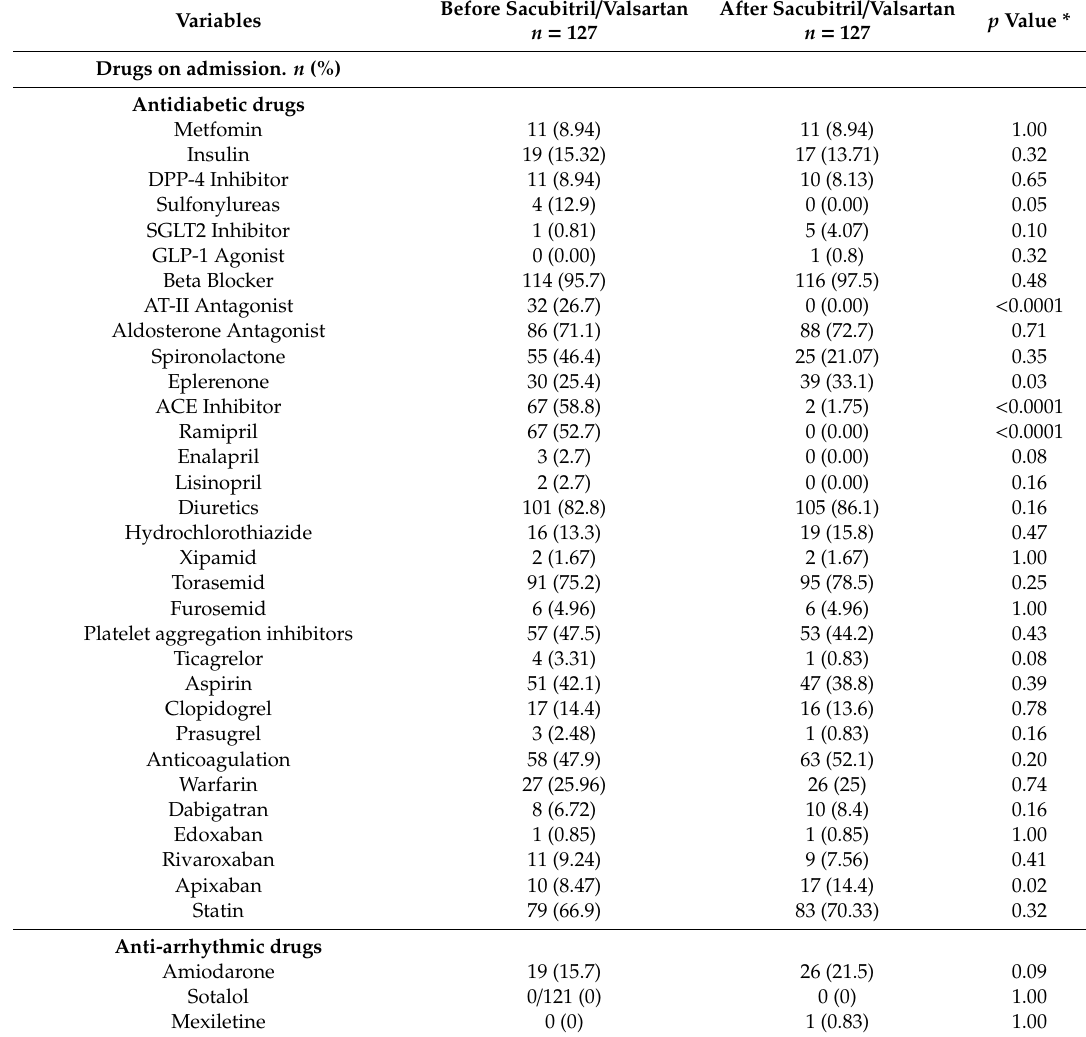
Table 2. Treatment of 127 patients before and after initiation of sacubitril / valsartan. Before Sacubitril / Valsartan After Sacubitril / Valsartan p Value * Variables n = 127 n = 127 Drugs on admission. n (%) Antidiabetic drugs Metfomin 11 (8.94) 11 (8.94) 1.00 Insulin 19 (15.32) 0.32 DPP-4 Inhibitor 11 (8.94) Sulfonylureas